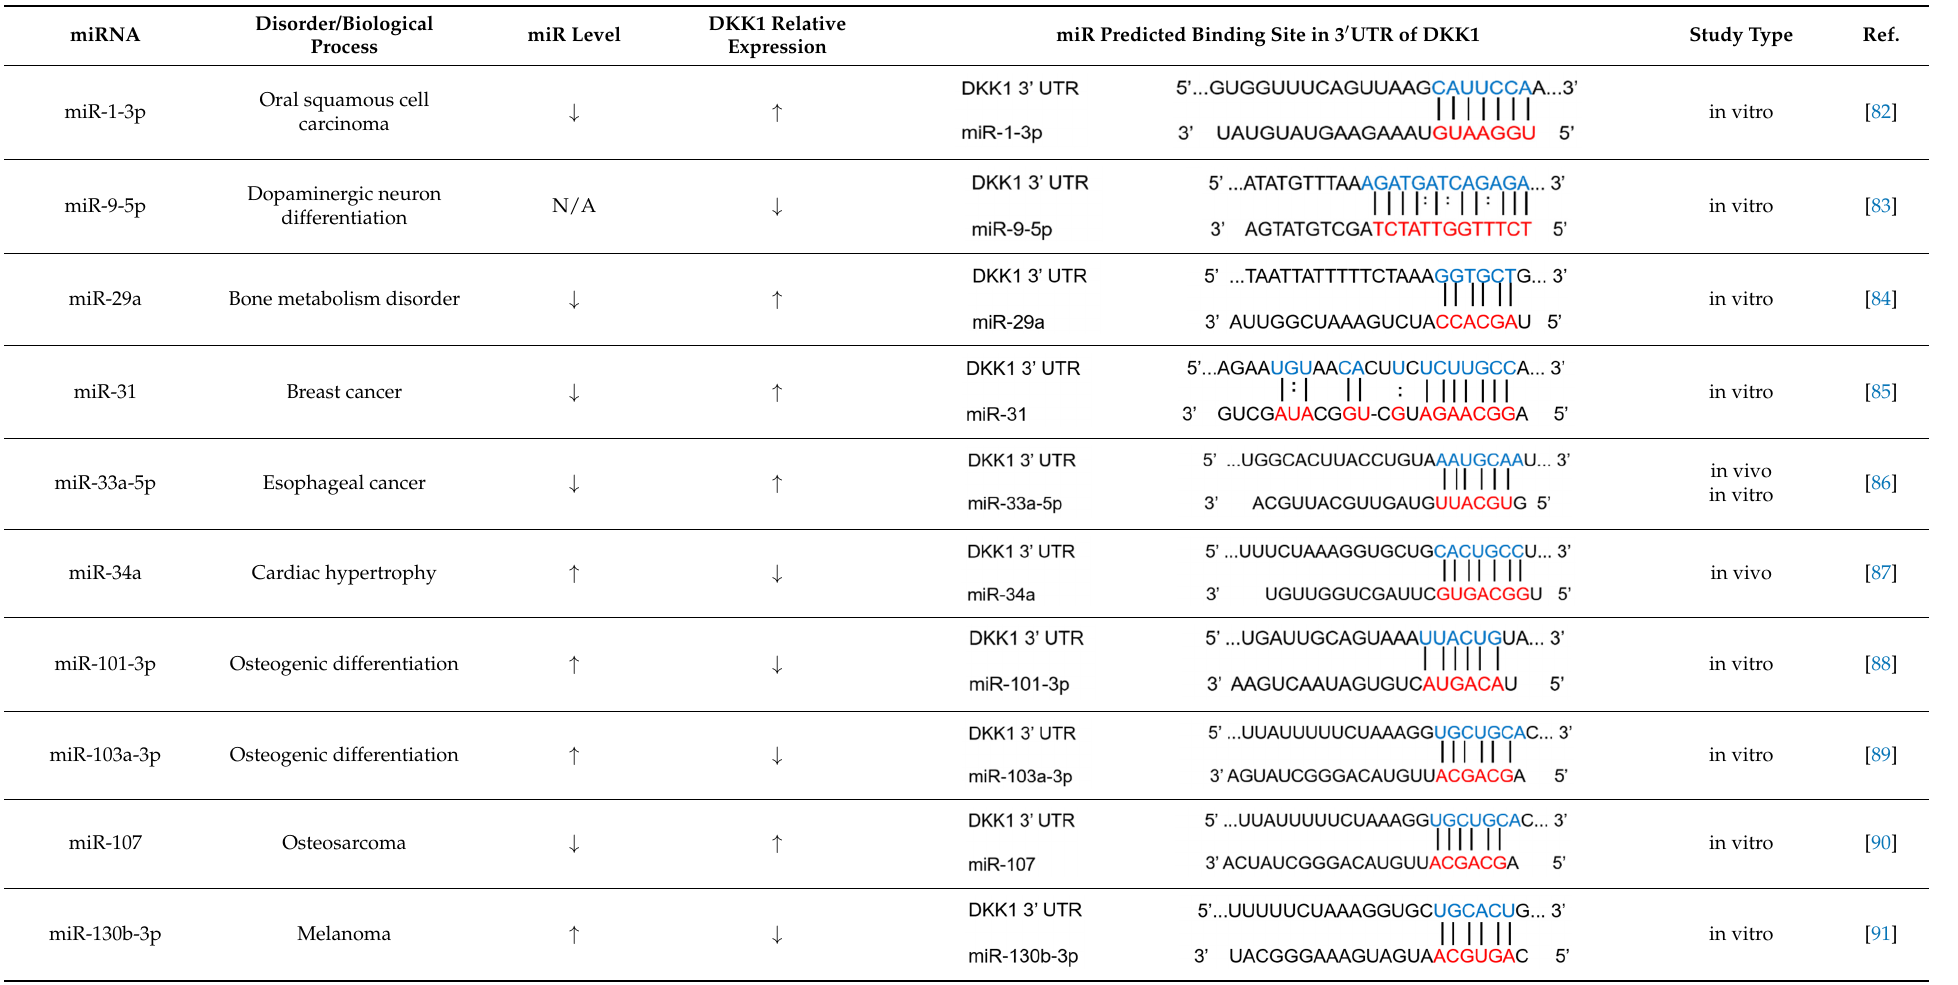
Table 1. Recent studies referring to miRNAs that directly target DKK1 and the association with certain disorders/biological processes.